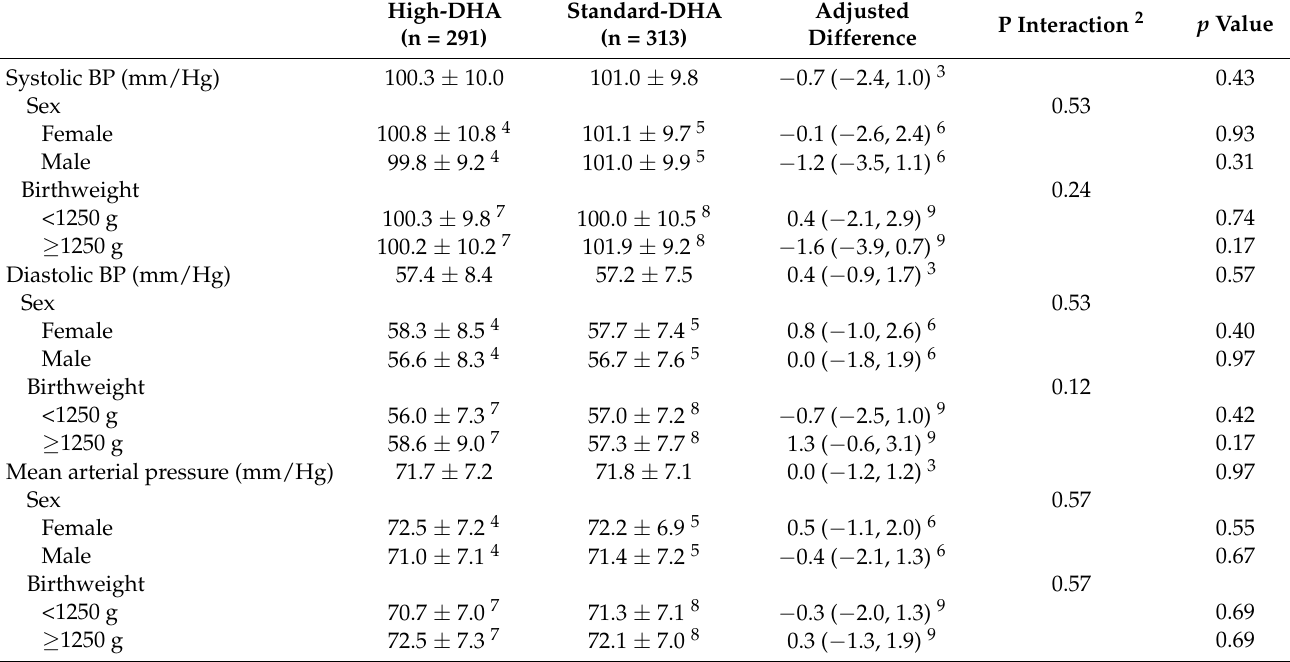
Table 6. Comparison of blood pressure measures at 7-year corrected age, by treatment group and by sex at birth and birthweight strata by treatment group 1